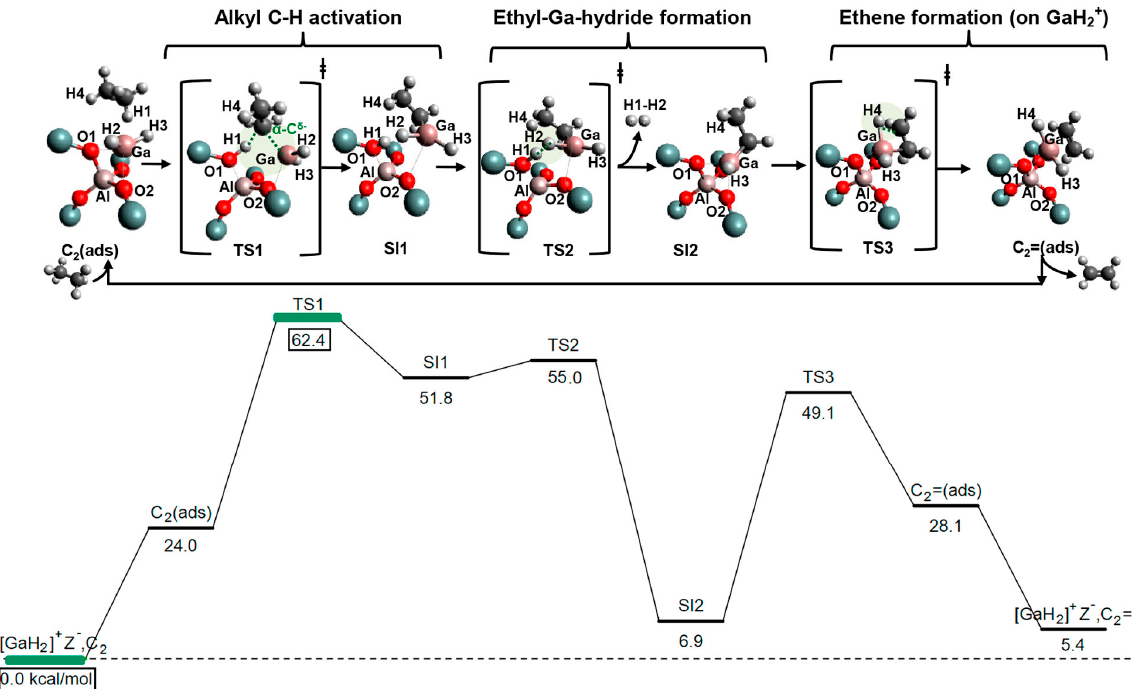
Figure 27. Ethane dehydrogenation via a stepwise alkyl mechanism on [GaH 2 ] + and the corresponding free energy surface (kcal/mol) reported at 823 K and 1 atm. Reprinted with permission from ref [94]. Copyright 2018 American Chemical Society.